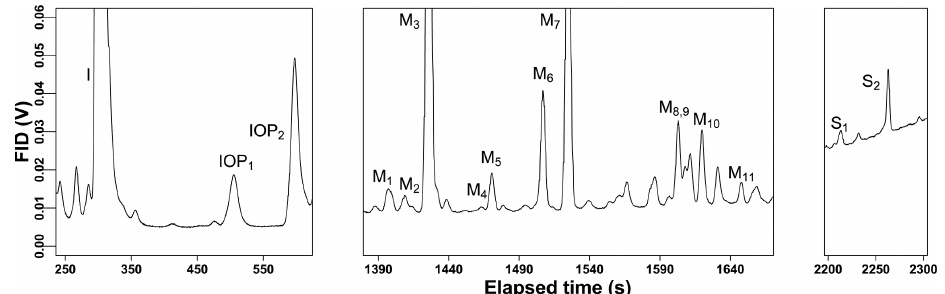
Figure 2. A typical GC chromatogram of sampled ambient air collected at the site. The compounds identified on the figure show the range of species found by the instrumental methods. These include isoprene (I), isoprene oxidation products (IOP), monoterpenes (M), and sesquiterpenes (S). Unlabeled peaks were not identified to be terpenes or isoprene oxidation products and are, in most cases, identifiable as belonging to a different compound class.